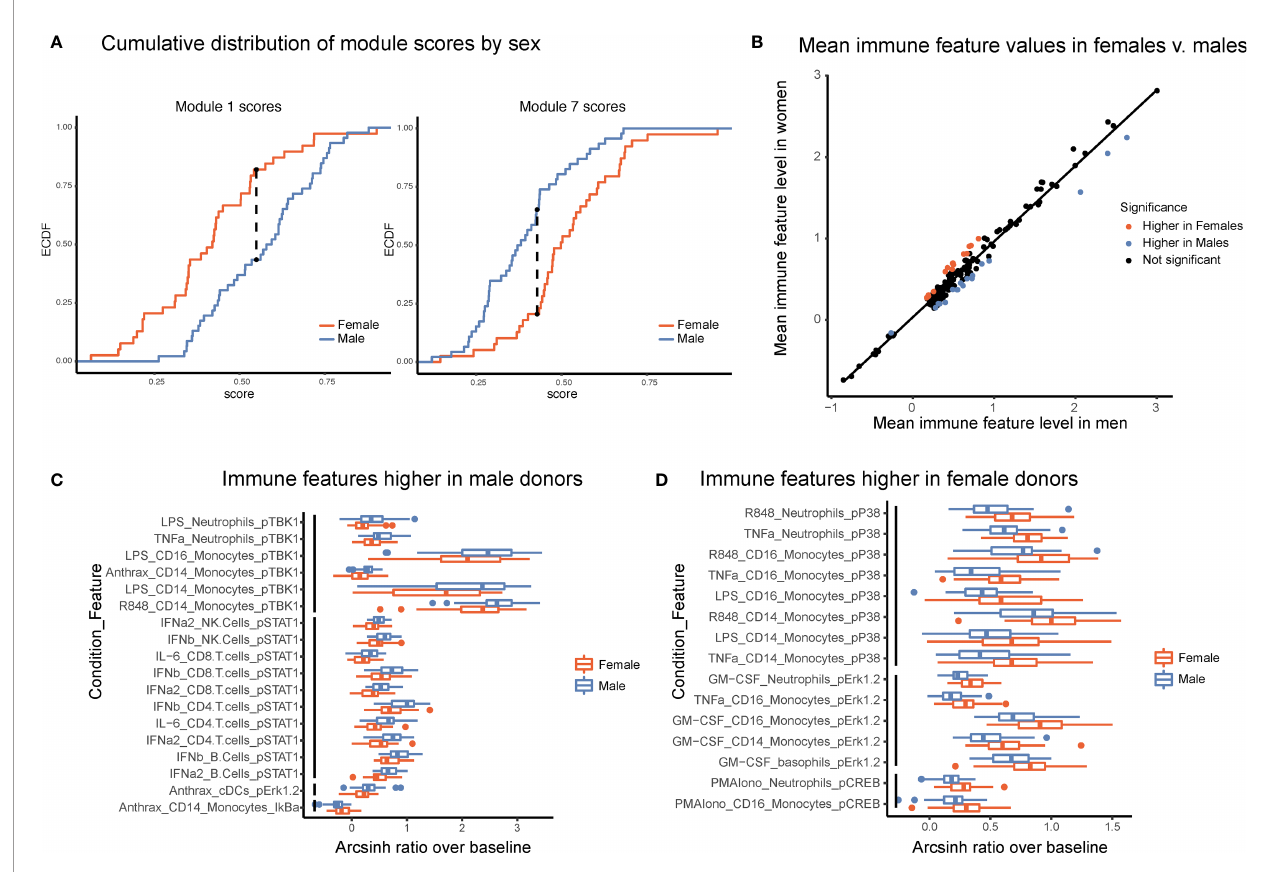
FIGURE 5 | Males and females have distinct immune response pro fi les. (A) Modules with signi fi cantly different module scores between males and females. Empirical cumulative distribution function (ECDF) shown for modules scores from module 1 (left) and module 7 (right). Dashed line shows the maximum distance between distributions. Signi fi cance determined by Kolmogorov-Smirnov test, adjusted p-value <.05. (B) Mean levels of each feature in samples from female donors versus male donors. Red indicates signi fi cantly higher in females; blue, signi fi cantly higher in males; and black, not signi fi cantly different based on an FDR < 1% (SAM unpaired). (C) Boxplots of the features signi fi cantly higher in males (FDR < 1%, SAM unpaired). Features are grouped by signaling protein (black bars). Decreased IkBa plotted with male donors to re fl ect increased degradation of IkBa leading to higher levels of p-NFkB. (D) Boxplots of the features signi fi cantly higher in females (FDR < 1%, SAM unpaired). Features grouped by signaling protein (black